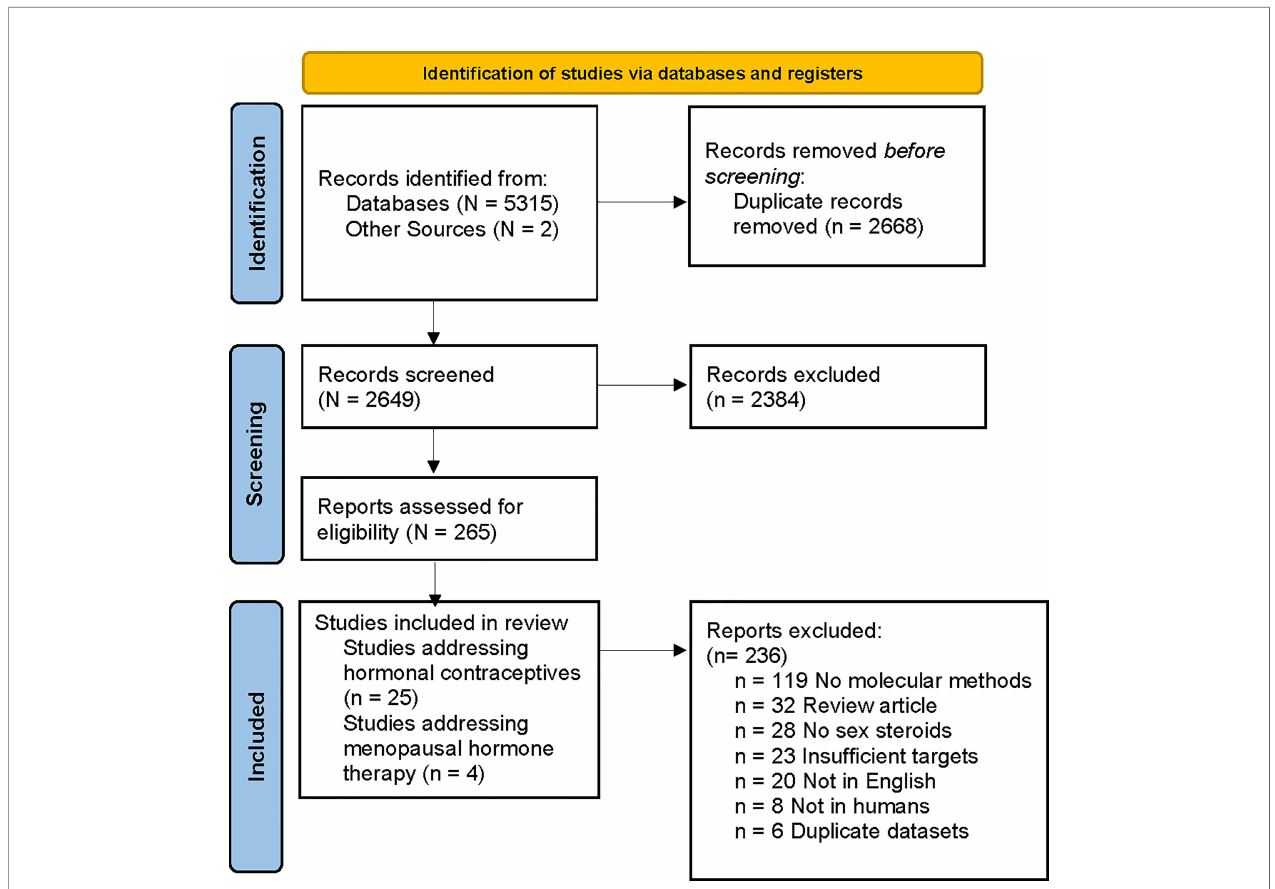
FIGURE 1 | PRISMA fl ow diagram of literature search and article selection. Flow chart adapted from Page et al. (2021).